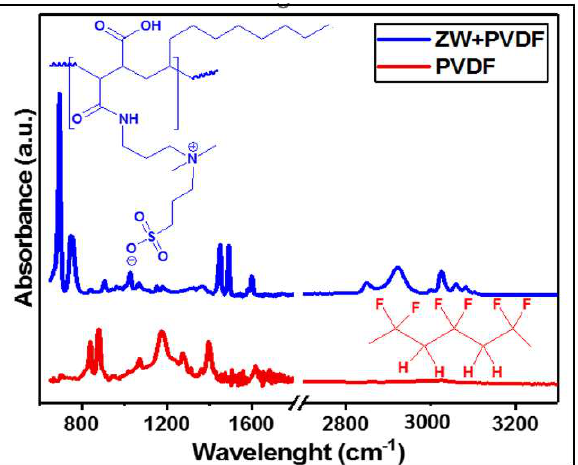
Figure 3. ATR-FTIR of unmodified PVDF and zwitterionic-polymer-modified PVDF